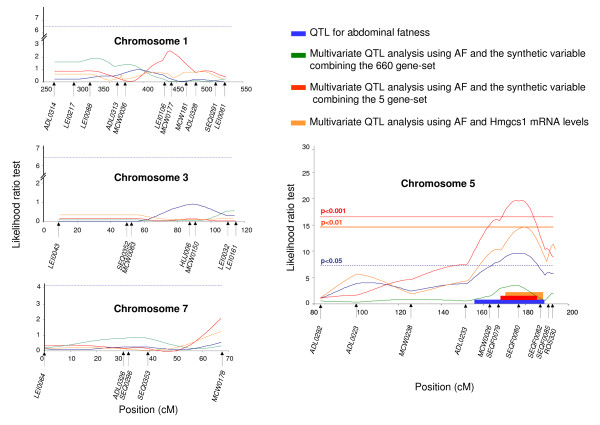
Detection on chromosomes 1, 3, 5 and 7 of QTL for AF trait using a single trait or multi-trait model. The multi-trait model concerned the AF trait combined with the HMGCS1 gene or the synthetic variable combining the 660 gene-set or the 5 gene-set. The chromosome-wide significance threshold at the 5% level for the AF QTL analysis (- - -) is indicated by a dashed blue horizontal line. On chromosome 5, the 1‰ level threshold (-) for the multivariate QTL analysis using AF and the synthetic variable combining the 5 gene-set is indicated by a red line. The genetic markers and genetic distances (cM) are shown on the X-axis. The likelihood ratio test (LRT) is shown on the Y-axis.